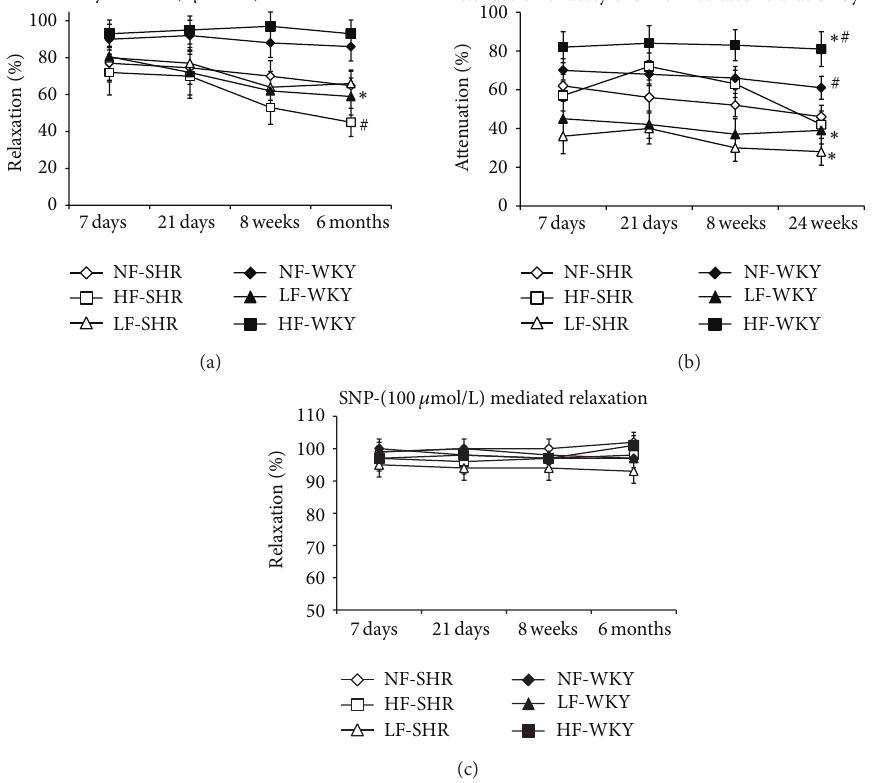
Figure 4: Acetylcholine- (1 𝜇 mol/L) mediated relaxation (a), percentage attenuation of acetylcholine-mediated relaxation by L-NAME (b), and sodium nitroprusside- (SNP, 10 𝜇 mol/L, (c)) mediated relaxation determined in mesenteric resistance arteries isolated from WKY rats and SHRs submitted to low flow (LF), high flow (HF), or normal flow (NF) for 1, 3, 8, or 24 weeks. Values represent mean ± SEM ( 𝑛 = 12 rats per group). ∗ 𝑃 < 0.01 , HF or LF versus NF arteries. # 𝑃 < 0.05 , SHRs versus WKY rats, within equivalent arteries (NF, LF, or